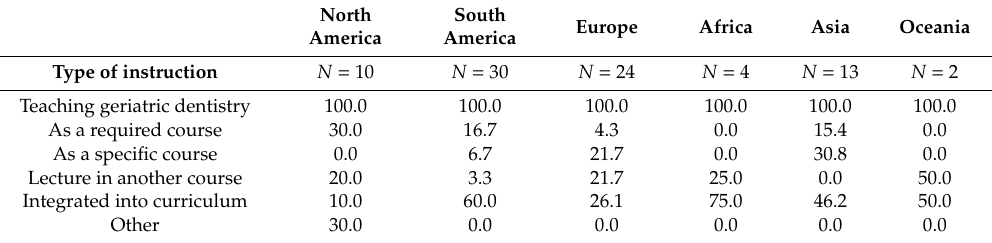
Table 2. Method of didactic teaching of geriatric dentistry by percentage of total respondents ( N = 83). North America